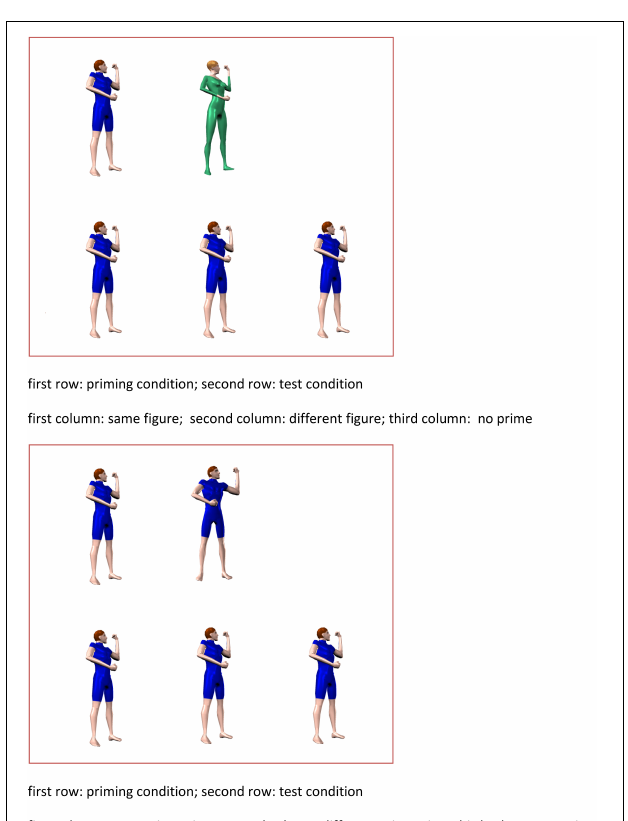
FIGURE 5 | Illustration of the priming conditions in Experiment 1. Top panel: same orientation/different figure condition; bottom panel: different orientation/same figure condition. First row in first panel: priming condition (same or different figure and same orientation, or no prime). First row in second panel: priming condition (same figure and same or different orientation, or no prime). Second row in both panels: primed condition (here figure in 45 ◦